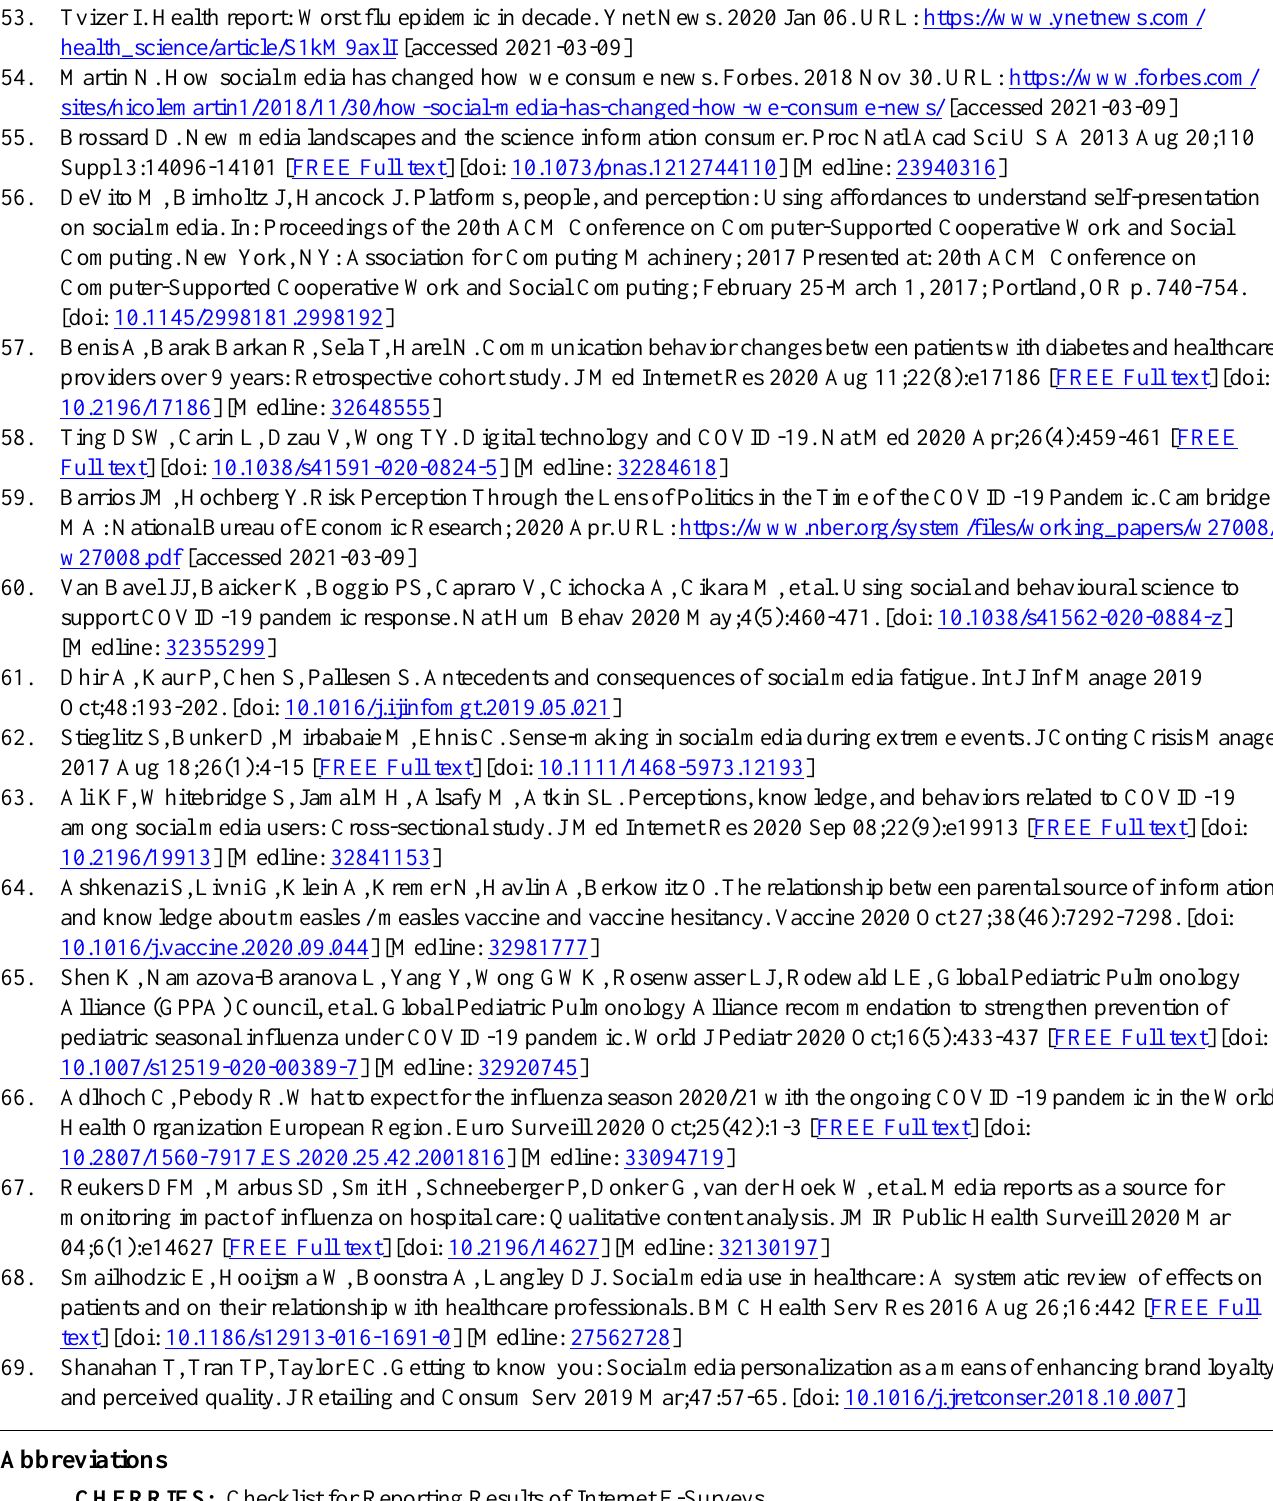
CHERRIES: Checklist for Reporting Results of Internet